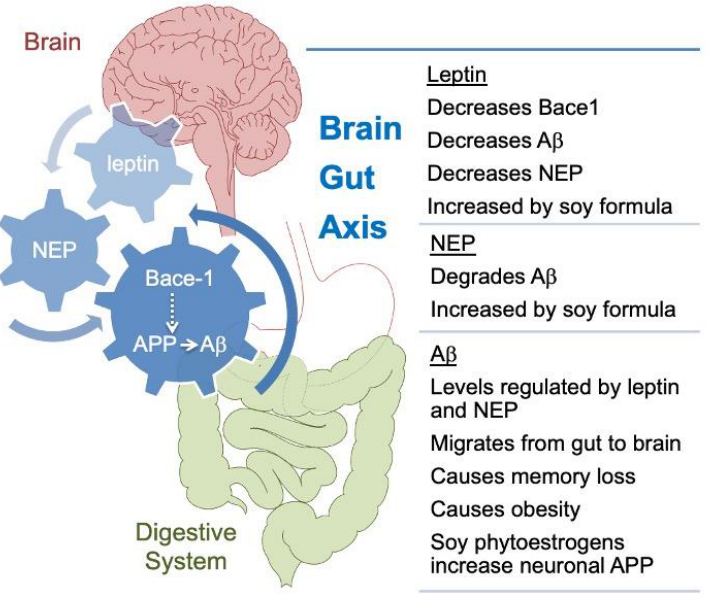
Figure 4. Model of proposed gut-brain interactions underlying soy effects in Fmr1 KO mice. SIF could contribute to increased weight gain through a pathway involving APP metabolism, leptin, and NEP.